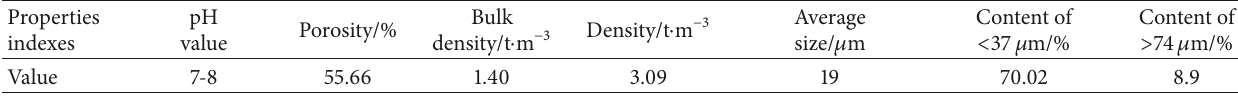
Table 2: Main tailings properties of Sijiaying.